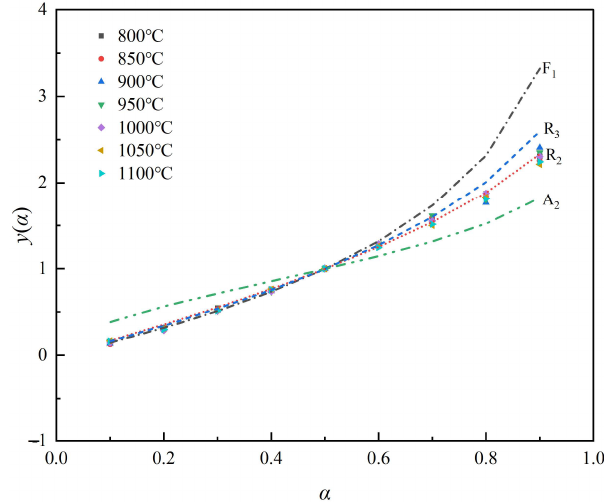
Figure 8. Standard curves and experimental data based on sharp analysis for samples.